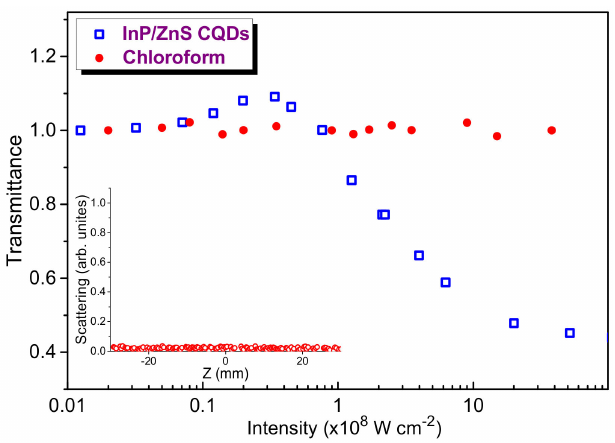
Figure 4. Optical limiting of 532 nm emission at different intensities of probe pulses. Red filled circles: intensity-dependent transmittance of chloroform. Blue empty squares: the same for InP@ZnS CQDs. Inset: dependence of scattered emission on the position of the 1-mm thick cell with regard to the focal plane of the focused probe